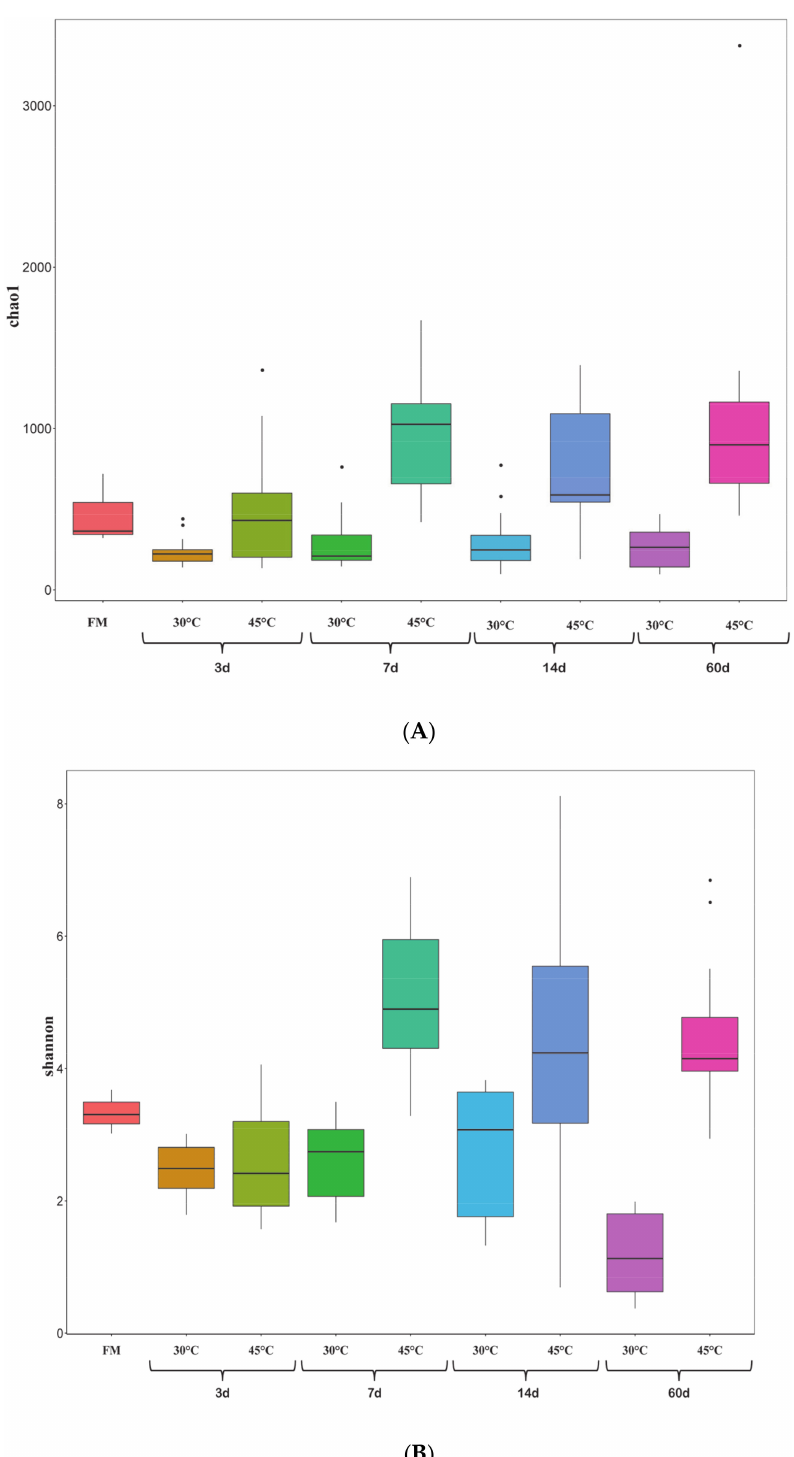
Figure 4. Community diversity and richness of the silages for every period: ( A ) Chao1 index of silage samples for every period (FM: fresh material; 3 d; 7 d; 14 d; 60 d); ( B ) Shannon index of silage samples for every period (FM: fresh material; 3 d; 7 d; 14 d; 60 d). Black dot means